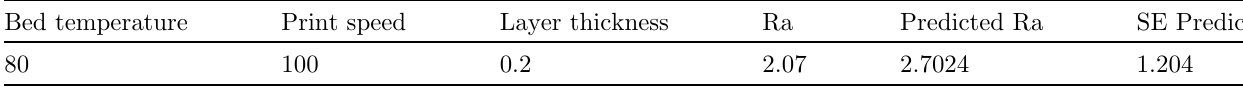
Table 9. Validation result for top surface roughness.